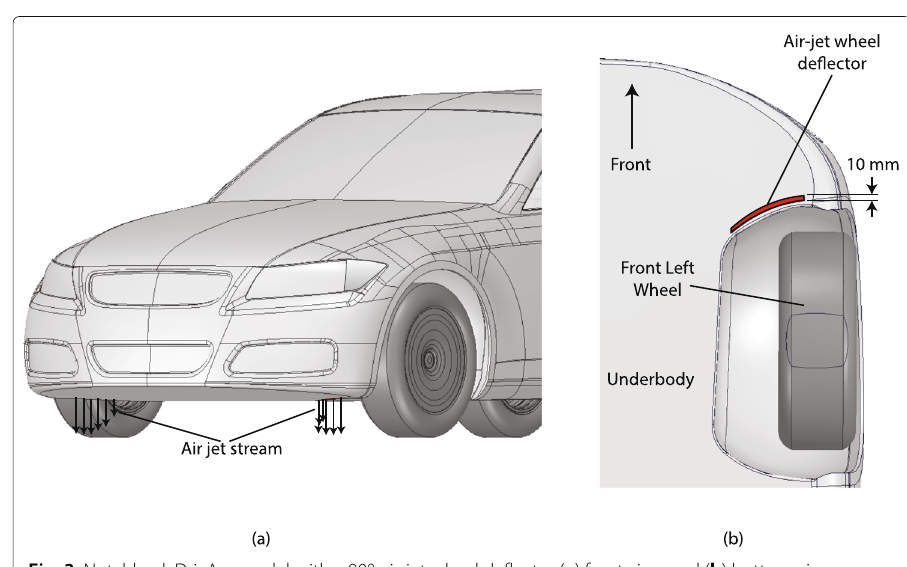
Fig. 3 Notchback DrivAer model with a 90 ◦ air-jet wheel deflector ( a ) front view and ( b ) bottom